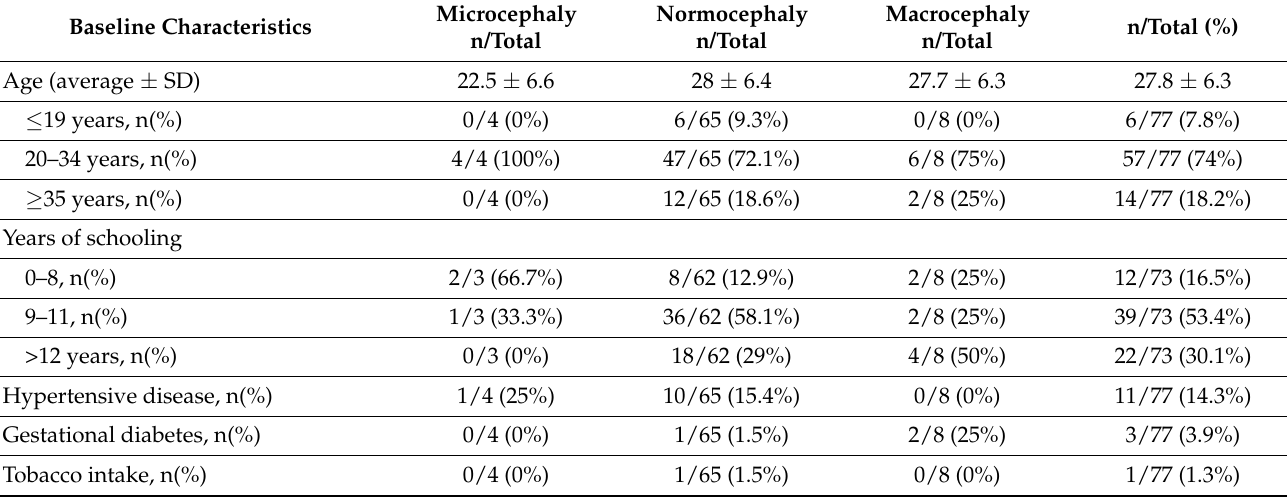
Table 1. Sociodemographic and clinical characteristics of 77 pregnant women with positive RT-PCR for Zika virus , distributed according to head circumference at childbirth, Manaus,